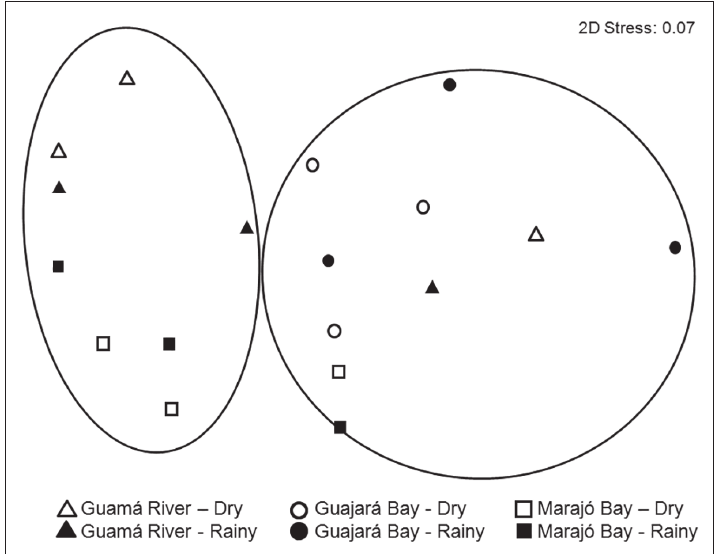
Figure 5 - Multivariate multidimensional scaling analysis by feeding guild by zone (Guamá River, Guajará Bay and Marajó Bay) and season (Dry and Rainy season), Amazon Estuary, northern